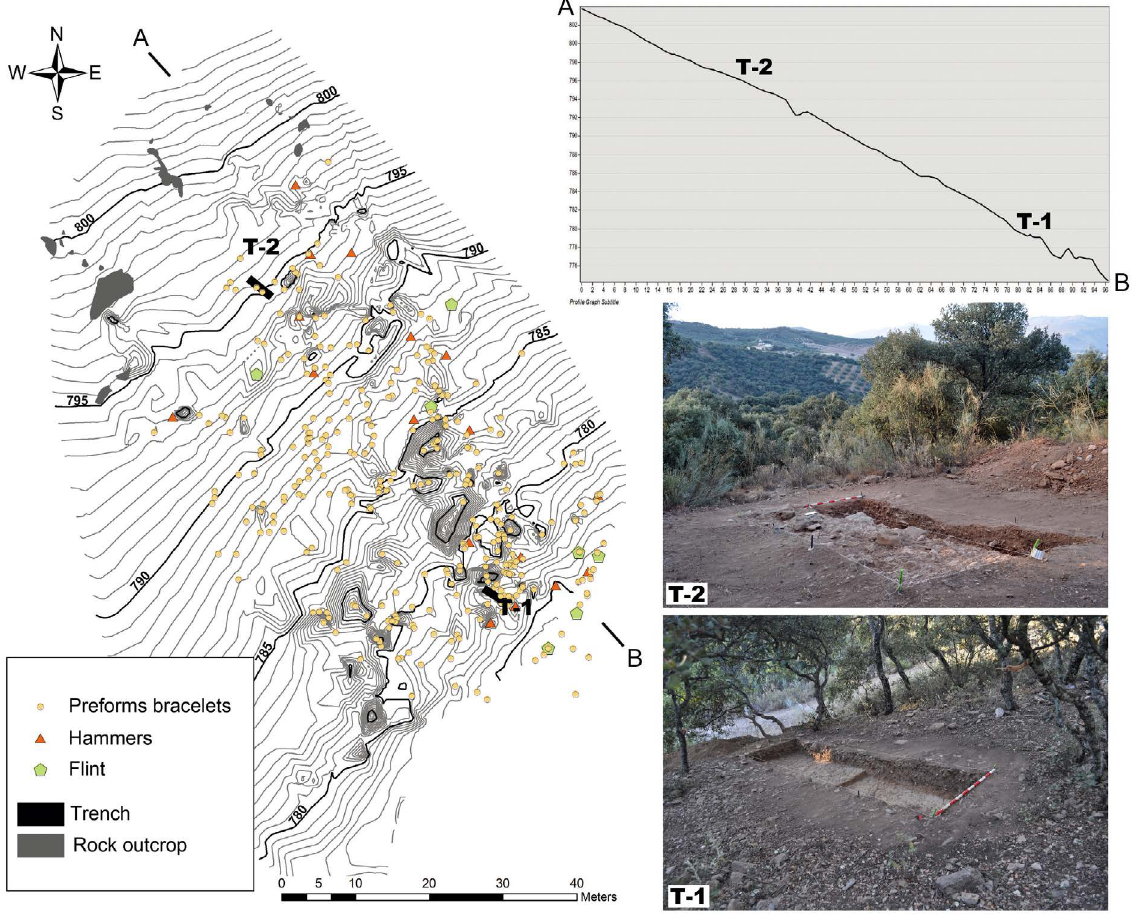
Figure 3. Superficial prospecting and two trenches excavated in relation with the